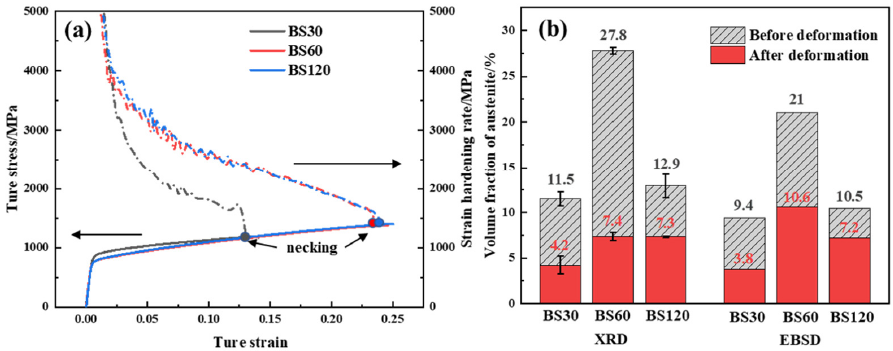
Figure 6. True stress–strain curves and work-hardening rate curves for samples BS30, BS60, and BS120 ( a ), the volume fraction of austenite before and after deformation, measured by XRD and EBSD ( b